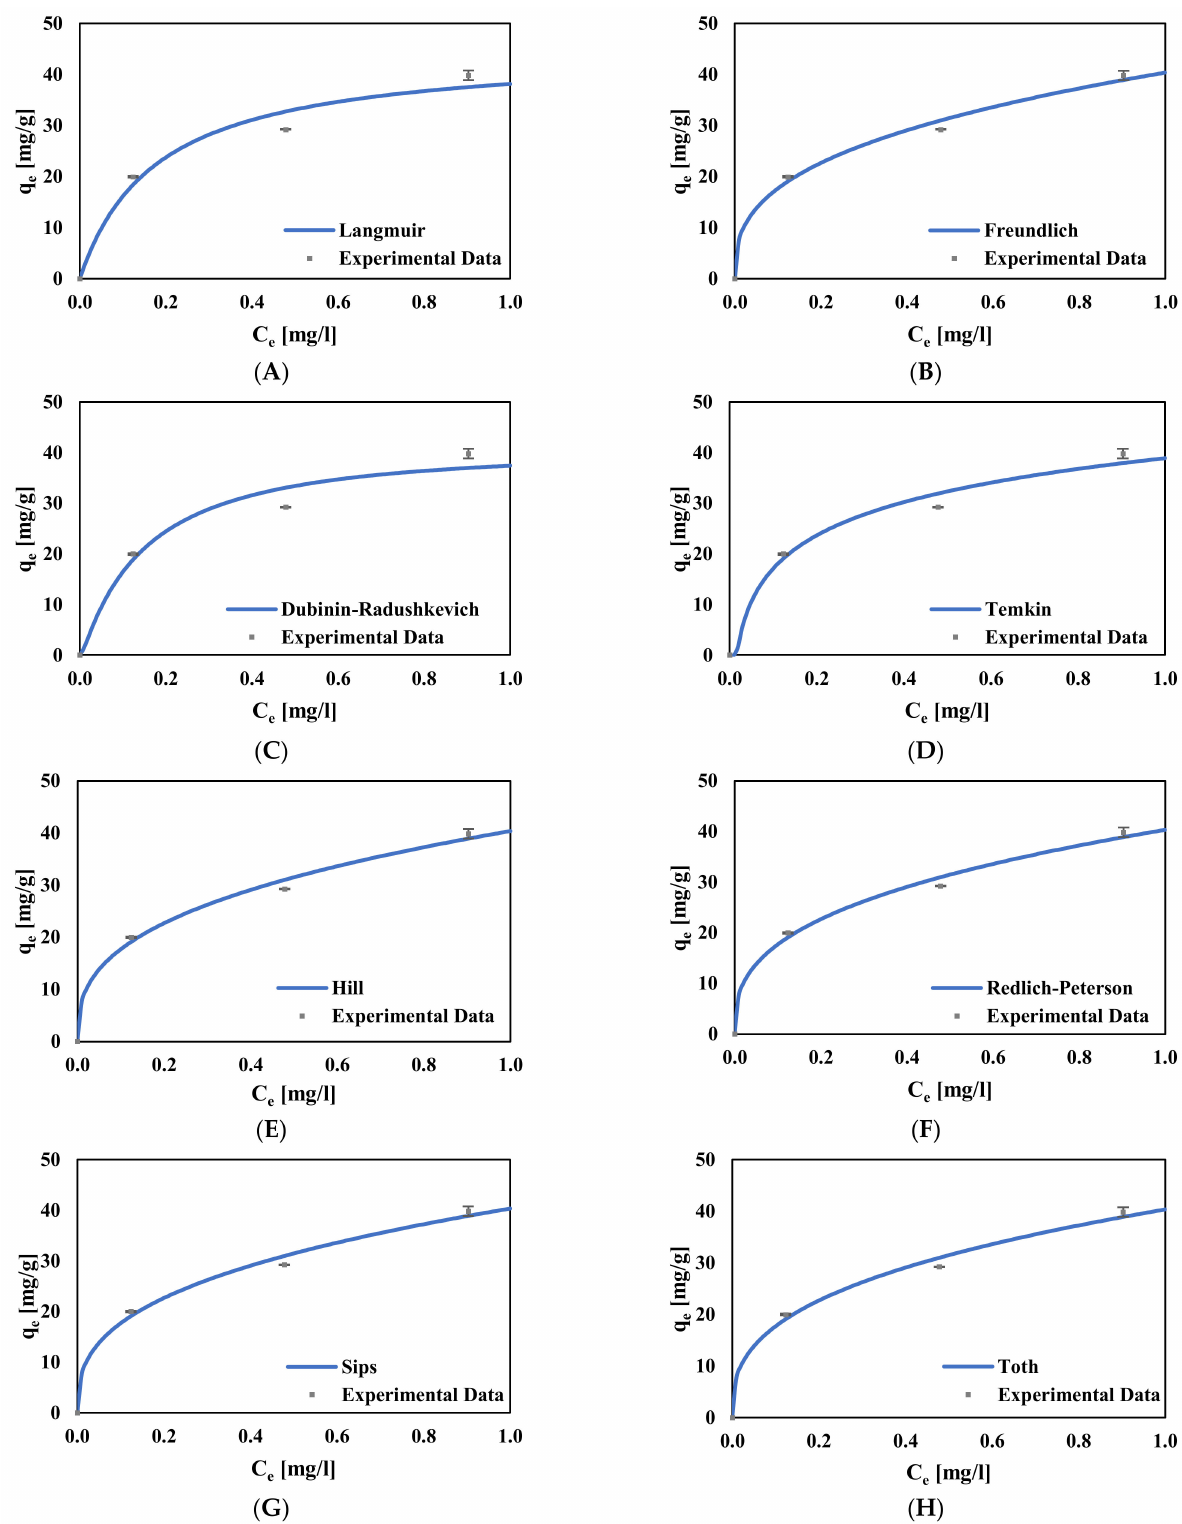
Figure 5. Nonlinear isotherm models: ( A ) Langmuir, ( B ) Freundlich, ( C ) Dubinin–Radushkevich, ( D ) Temkin, ( E ) Hill, ( F ) Redlich-Peterson, ( G ) Sips, ( H )